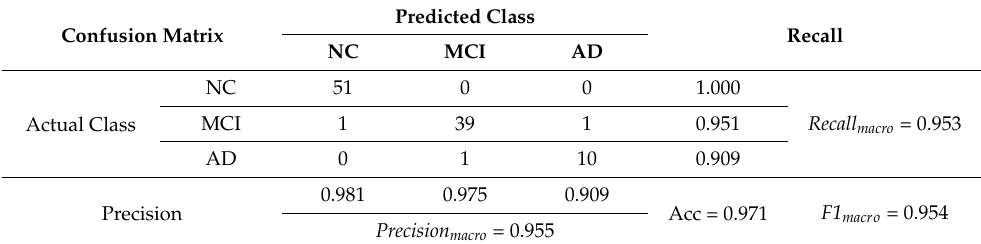
Table 3. Average confusion matrix and experimental